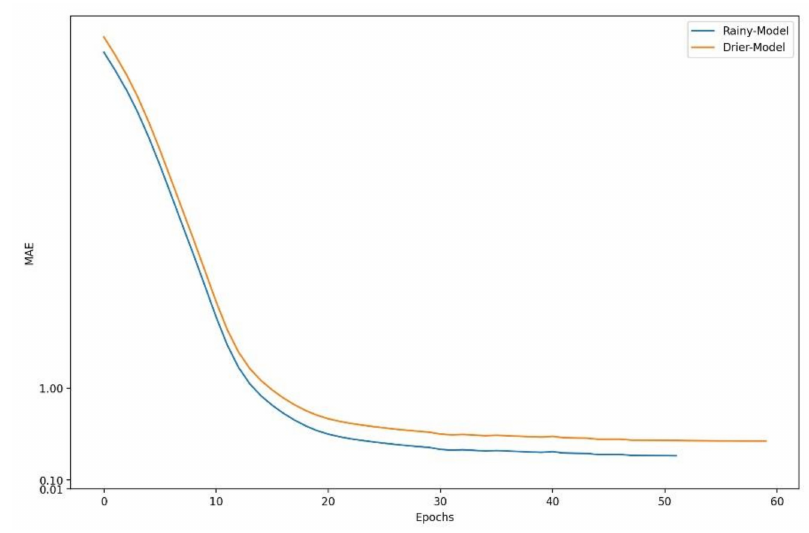
Figure 12. The learning curve of TabNet-PF.